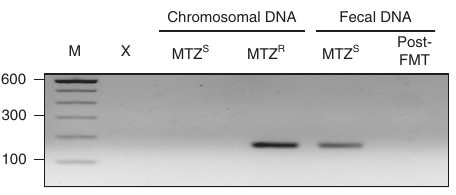
Fig. 5 pCD-METRO is detectable in fecal total DNA. pCD-METRO is detectable in fecal total DNA from the same sample from which a MTZ S RT020 C. dif fi cile was isolated. Shown are the results from a PCR targeting ORF6, but similar results were obtained for other plasmid-speci fi c primer sets. Source data are provided as a Source Data fi